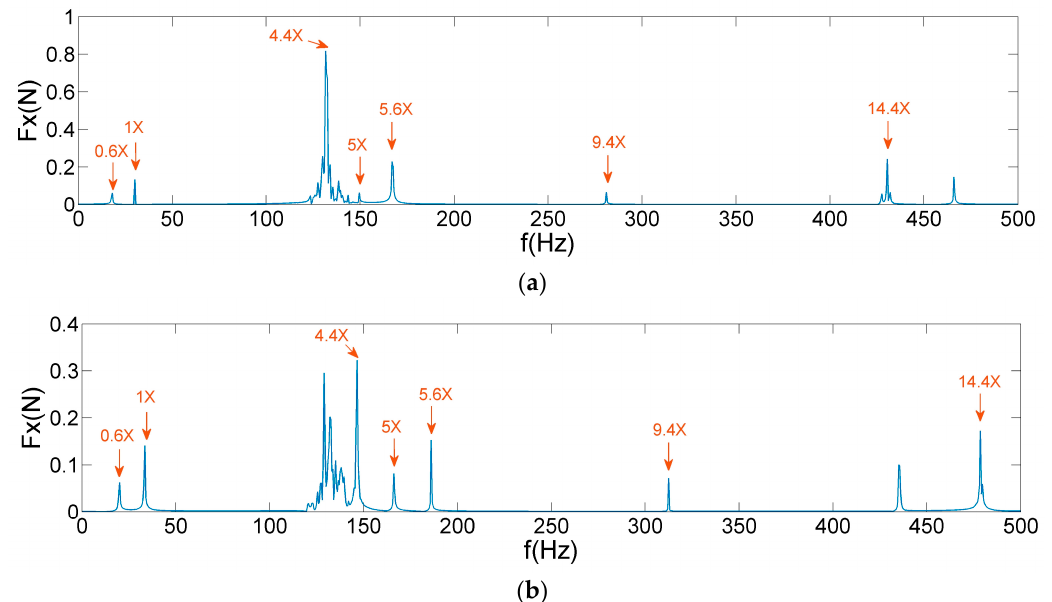
Figure 15. AIC–SVD denoised frequency spectrum of F x : ( a ) 1800 rpm; ( b ) 2000 rpm.